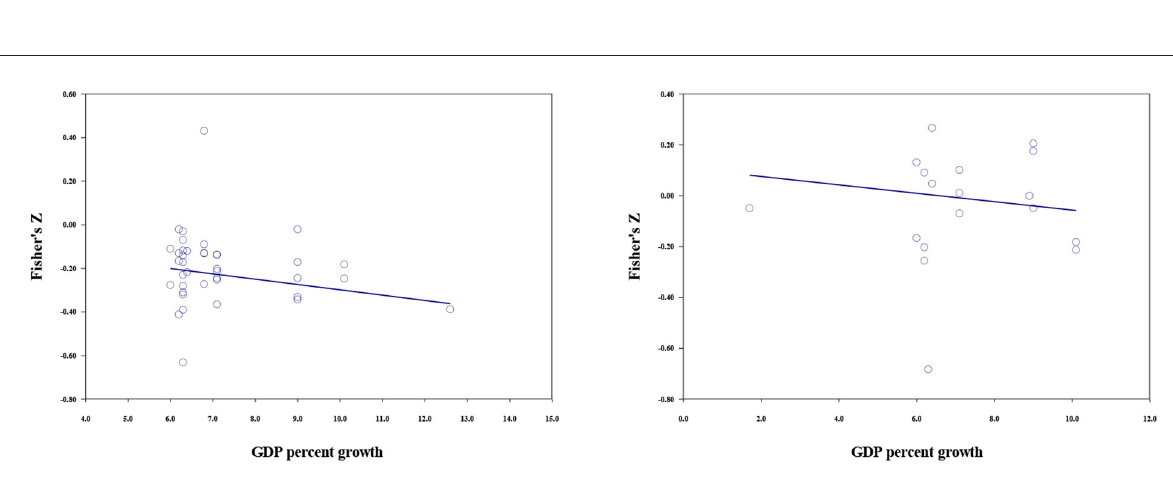
FIGURE6 The moderating effect of GDP percent growth; materialistic values (left), extrinsic aspirations